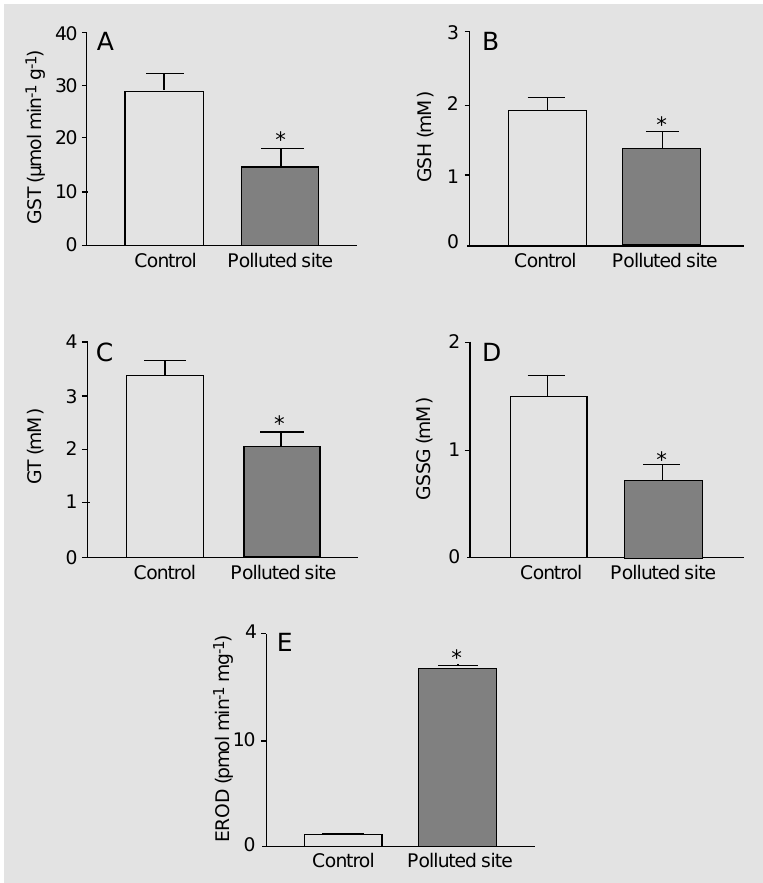
Figure 2. Comparison between different parameters measured in the liver of Geophagus brasiliensis collected at a reference site (control) and at a polluted site. A , Glutathione S- transferase activities (GST, µmol min -1 g -1 ); B , reduced glutathione (GSH, mM); C , total glutathione (GT, mM); D , oxidized glutathione (GSSG, mM); E , ethoxyresorufin- O -deethylase activities (EROD, pmol min -1 mg -1 ). *P<0.05 compared to control (Student t